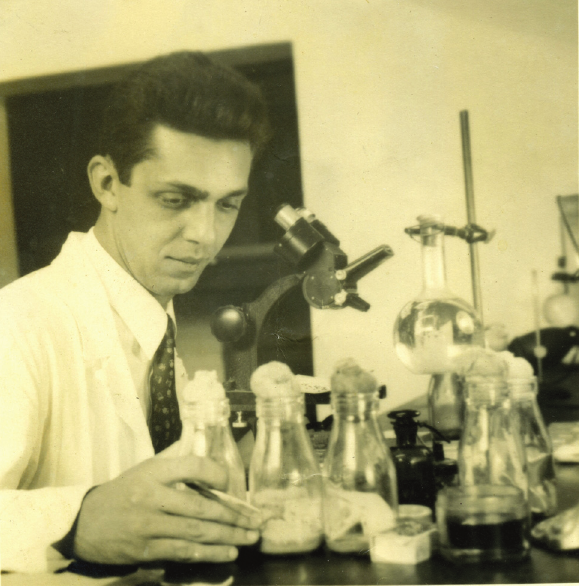
Figure 2 - Luiz Edmundo de Magalhães in his laboratory in the basement of the Jorge Street Mansion, in 1955 (archives of the first author).